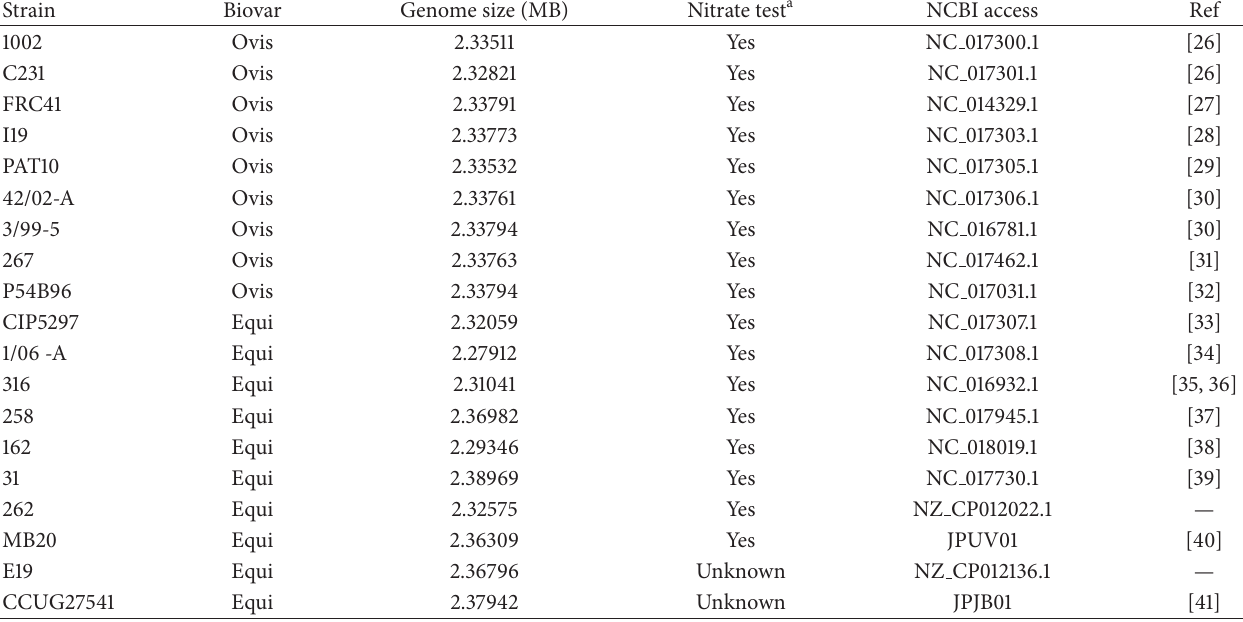
Table 1: Strains used in phenotypic and genotypic analysis regarding the nitrate reductase